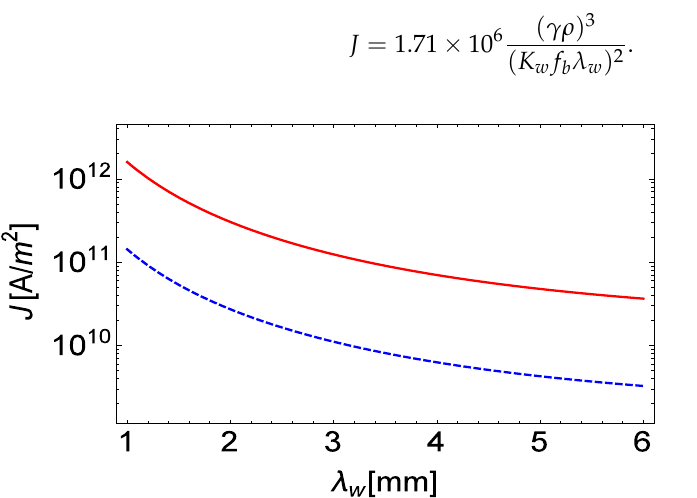
Figure 3. Electron beam current density (A/m 2 ) vs. the undulator wave length for λ r ≡ 1 nm (continuous line) and λ r ≡ 5 nm (dashed